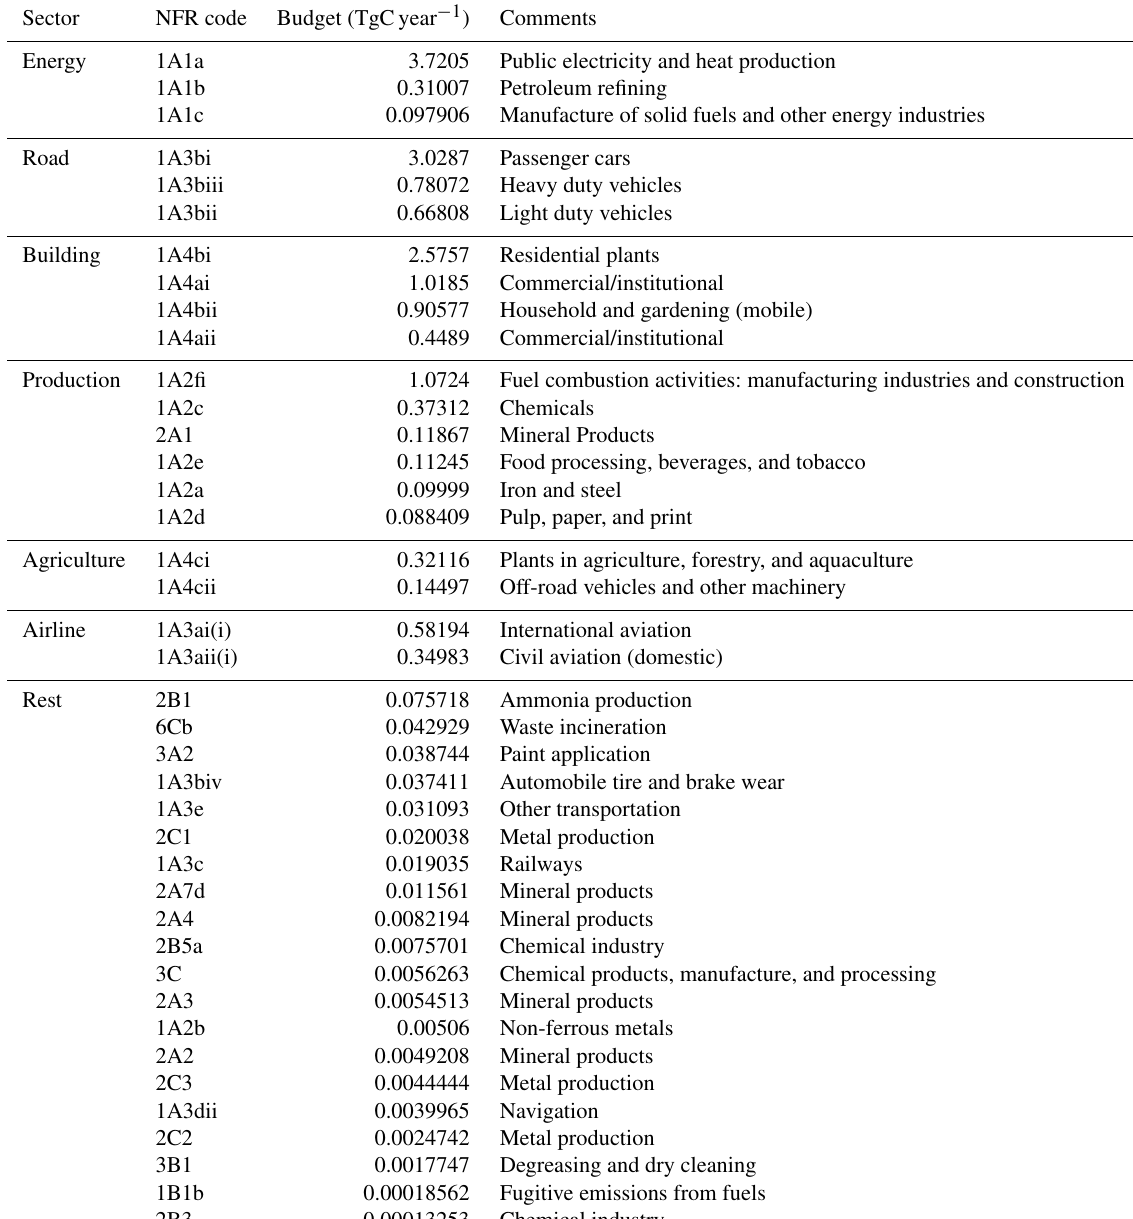
Table A1. Specification of the 40 sectors in the IER inventory employed in this study. These sectors are grouped into seven aggregate larger sectors listed in Table